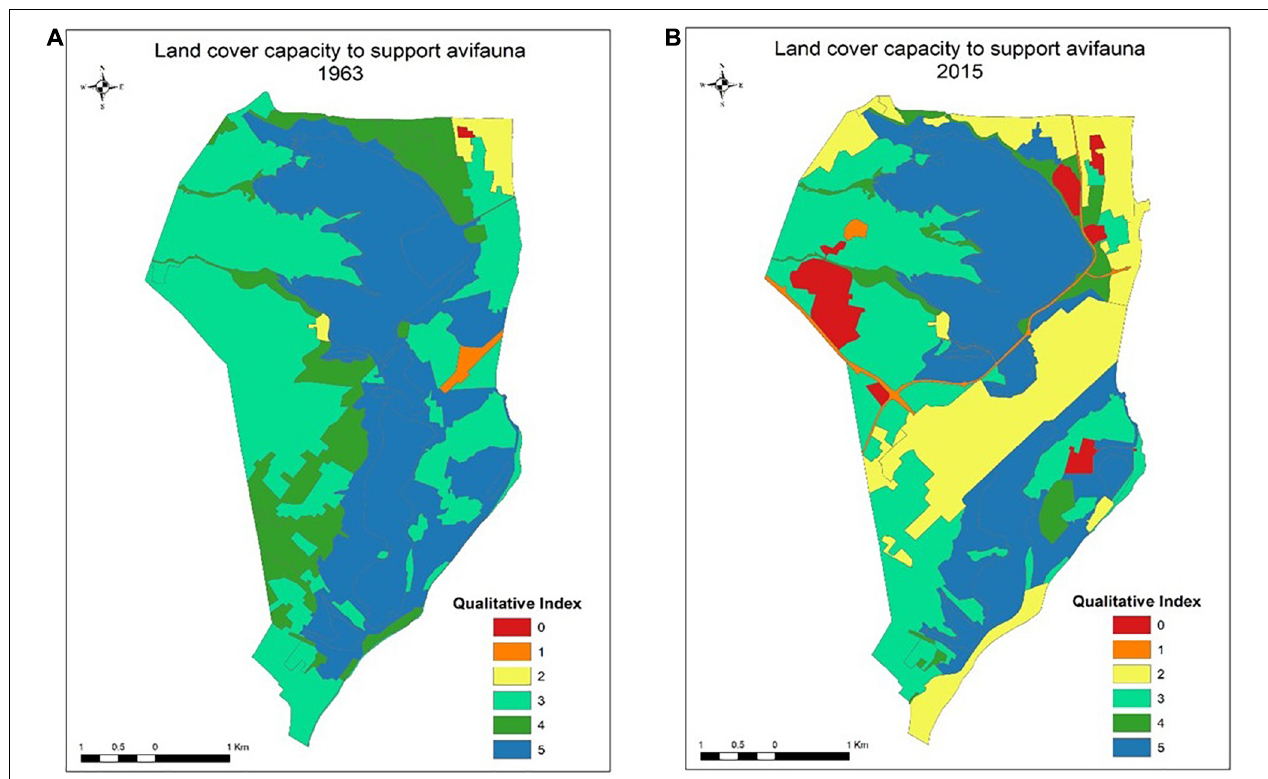
FIGURE 5 | Avifauna support in the area and the changes between 1963 (A) and 2015 (B) .